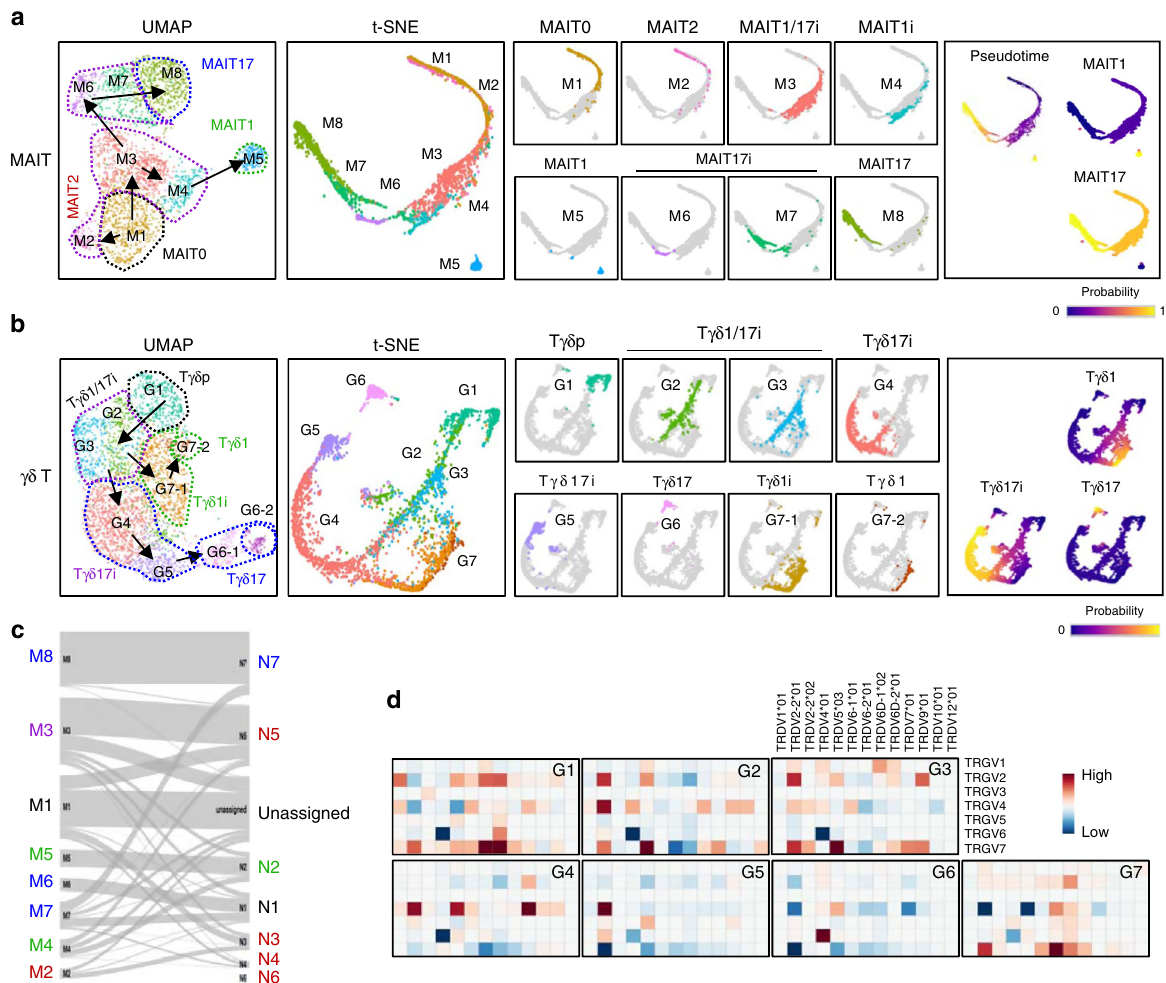
Fig. 3 Trajectory analysis predicts precursors of MAIT and γδ T cells. a , b Far left: UMAP plots of MAIT ( a ) and γδ T cells ( b ) show schematic representation of trajectories. Left to far right: t-SNE plots of MAIT ( a ) and γδ T cells ( b ) colored by cell clusters (left), Palantir pseudotime (right), and Palantir branching probabilities (far right). c Projections of the MAIT clusters to iNKT clusters by scamp-cluster. d Heat maps illustrate log 2 -transformed fold change of frequency of each TRGV/TRDV gene pair in a given cell cluster with respect to all γδ T